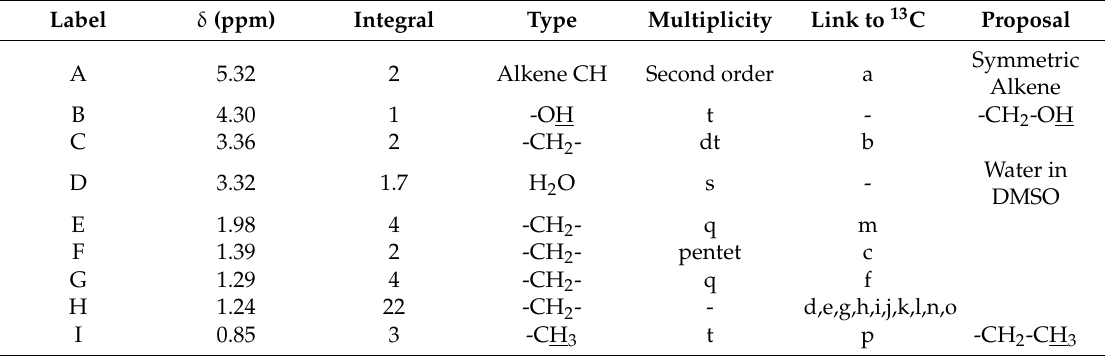
Table 1. Data arising from the 1D 1 H-NMR spectrum of the lipid component. Reference to the “link to 13 C” arises from analysis of the 2D [ 1 H, 13 C] HSQC-NMR spectrum that reveals 1 J HC correlations where labels a–q correspond to the 13 C resonances shown in (Figure